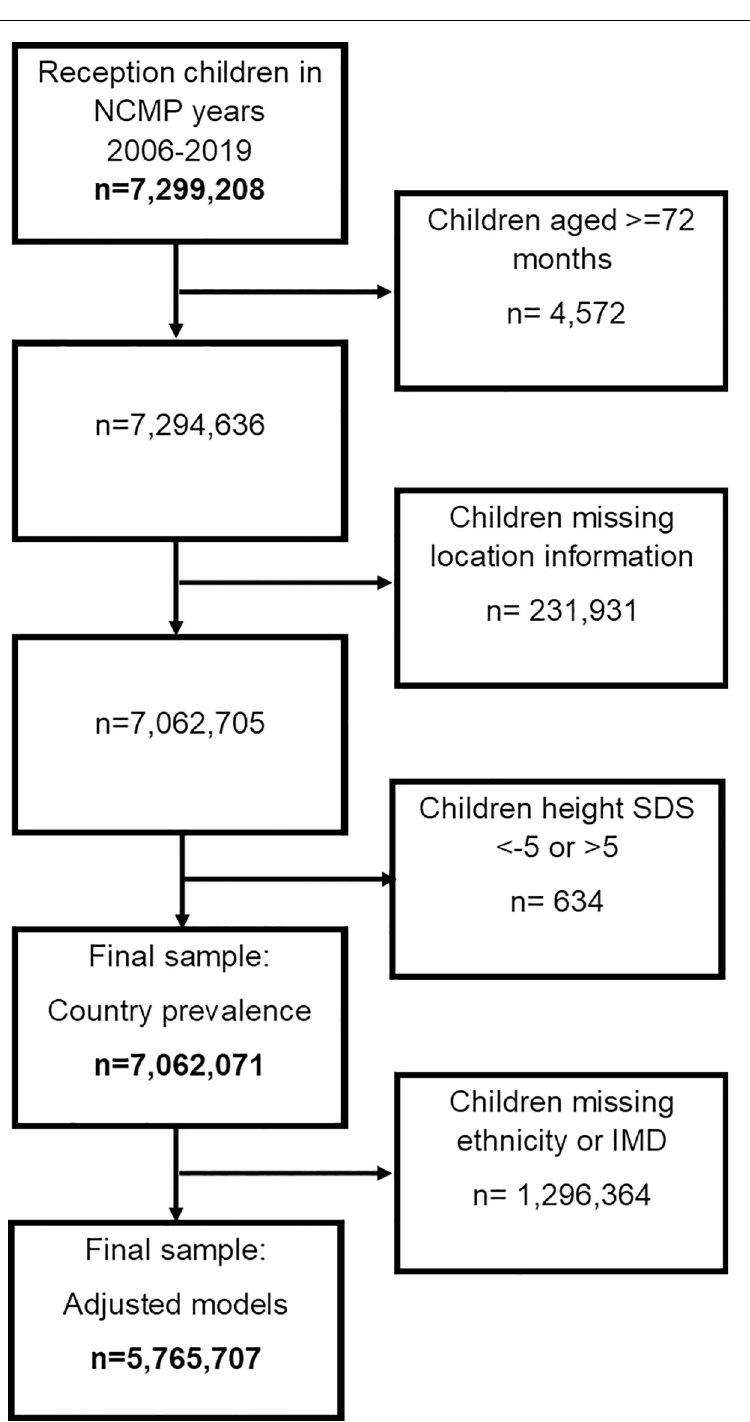
Fig 1. Sample inclusion and exclusion flowchart. I AU : AbbreviationlistshavebeencompiledforthoseusedthroughoutFigs 1 and 2 : Pleaseverifythatallentriesarecorrect : MD, index of multiple deprivation; NCMP, National Child Measurement Programme; SDS, standard deviation score. https://doi.org/10.1371/journal.pmed.1003760.g001 the period between 2006 and 2019, 1.93% (95% confidence interval (CI): 1.92 to 1.94) of chil- dren aged 4 to 5 years were short for their age in England. Girls had a higher prevalence of short stature, with 2.09% (2.07 to 2.10) of girls compared with 1.77% (1.76 to 1.78) of boys